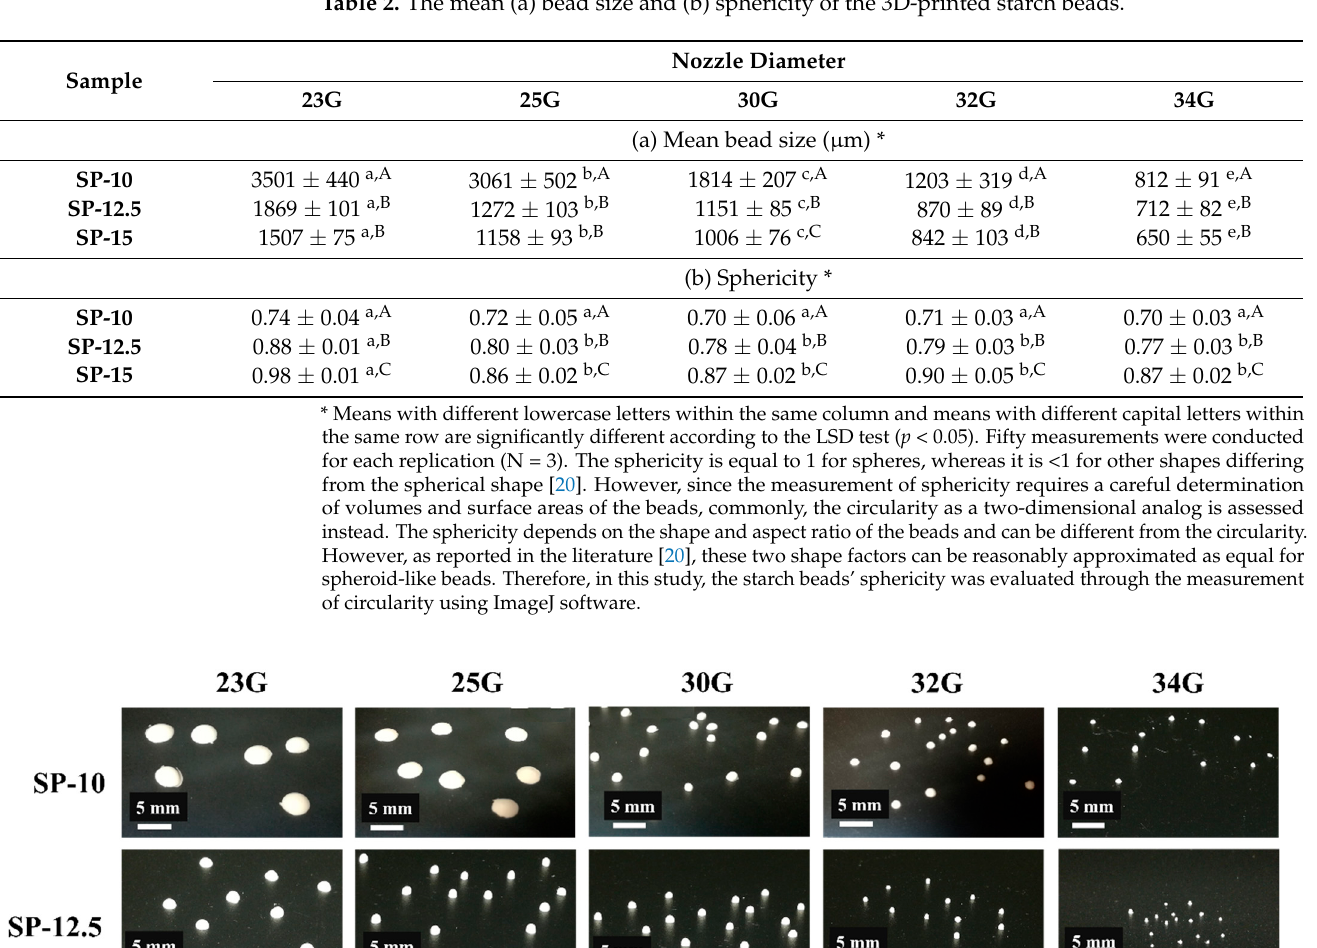
Table 2. The mean (a) bead size and (b) sphericity of the 3D-printed starch beads.